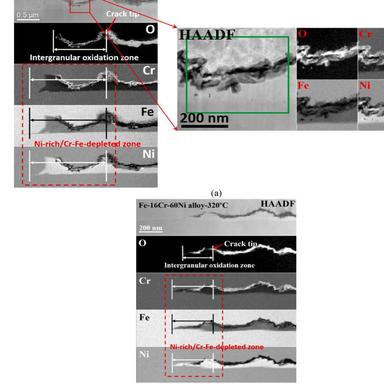
HAADF images and qualitative EELS elemental maps of representative SCC crack tips prepared from Fe-16Cr-60Ni alloy tested at (a) 360 ◦C and (b) 320 ◦C.